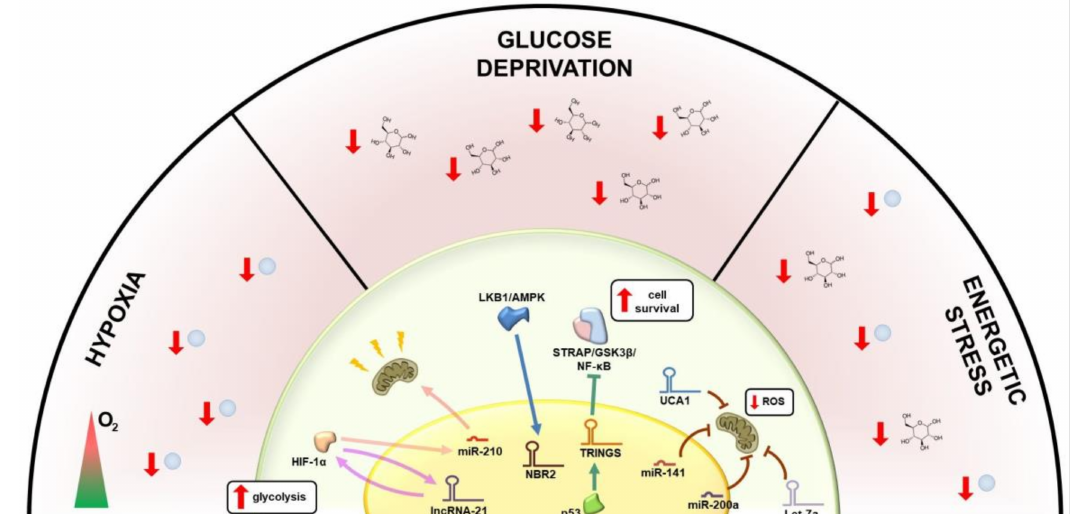
Figure 1. Non-coding RNAs promote the ability of cancer cells to survive in a hostile microenvironment. Low-oxygen conditions, glucose deprivation and energetic stress are major inductors of perturbation in non-coding RNA expression and interaction with cellular metabolism. Under hypoxic conditions, the cross-talk between the transcription factor HIF-1 α (hypoxia-inducible factor 1-alpha) lncRNA-21and miR-210 suppresses mitochondrial function and promotes glycolysis. Glucose starvation up-regulates the lncRNA TRINGS (Tp53-regulated inhibitor of necrosis under glucose starvation), thus inhibiting the STRAP–GSK3 β –NF- κ B necrotic signaling: the liver kinase B1 (LKB1)/AMP-activated protein kinase (AMPK regulates the expression of the lncRNA NBR2 (neighbor of BRCA1 gene 2), resulting in cell cycle progression. miR-141, miR-200a, Let-7a and UCA1 participate in the fine-tuning of the oxidative phosphorylation in mitochondria thus modulating the oxidative